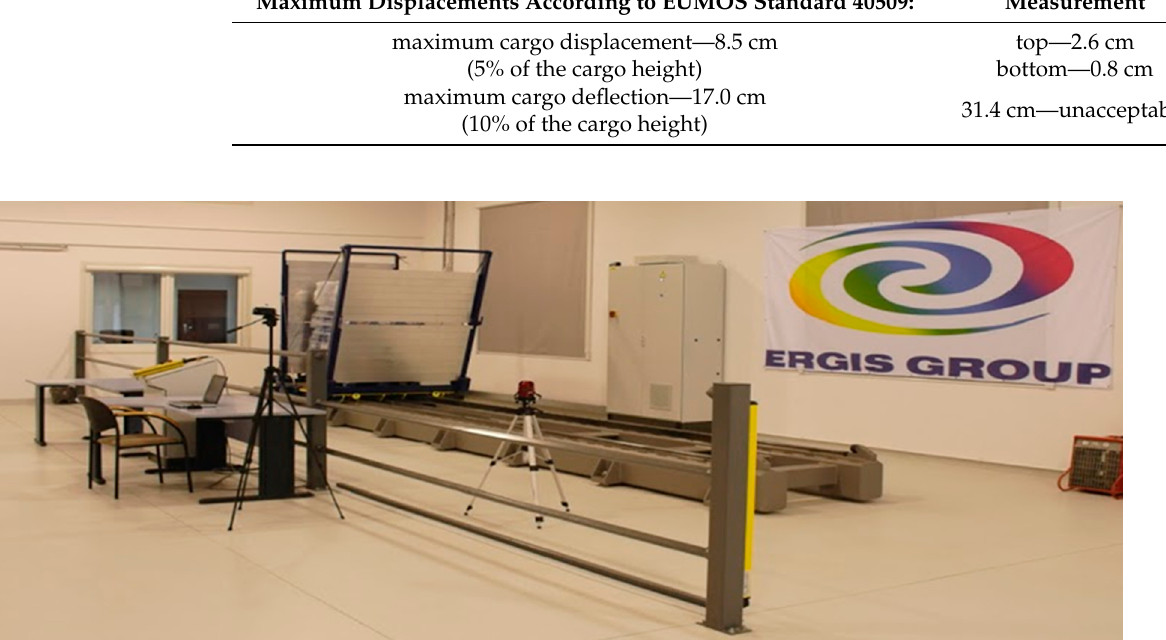
after the 0.4 g test